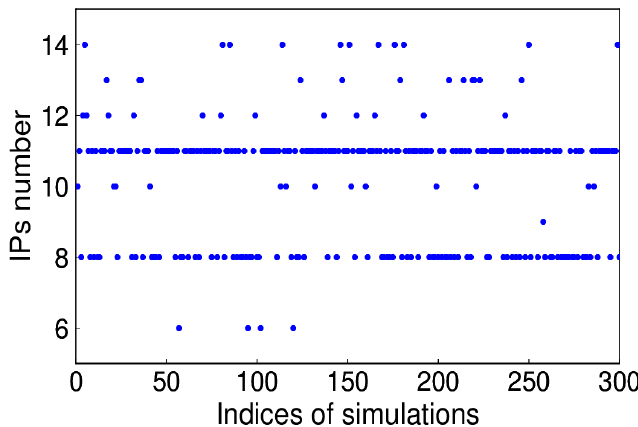
Figure 13. The optimal number of IPs determined on the minimum RMS criterion.